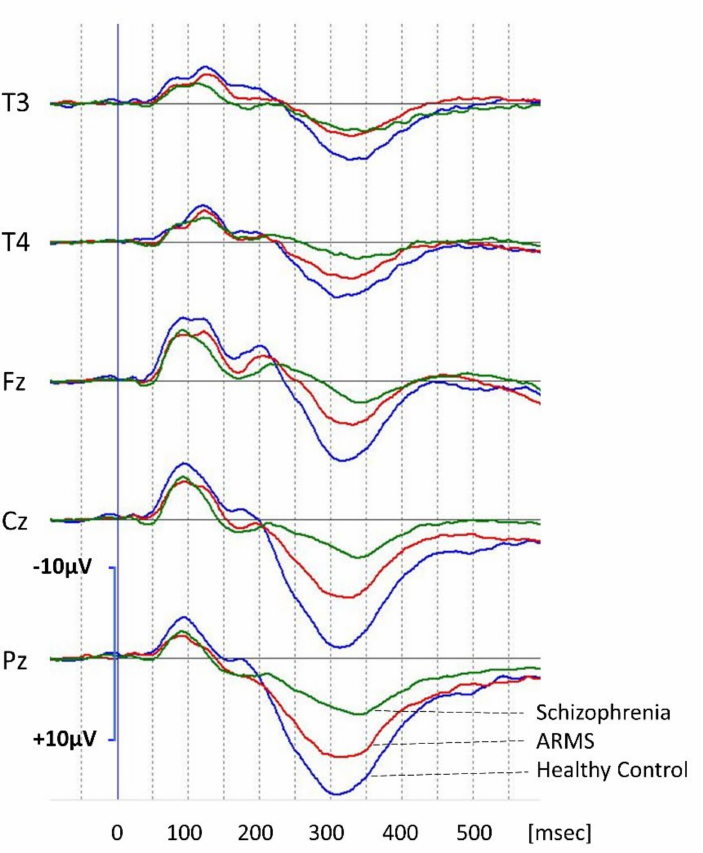
Figure 1. P300 waveforms at the T3, T4, Fz, Cz, and Pz leads. Grand average waveforms in healthy controls (Control, blue lines), subjects with at-risk mental states (ARMS, red lines), and patients with schizophrenia (Schizophrenia, green lines),